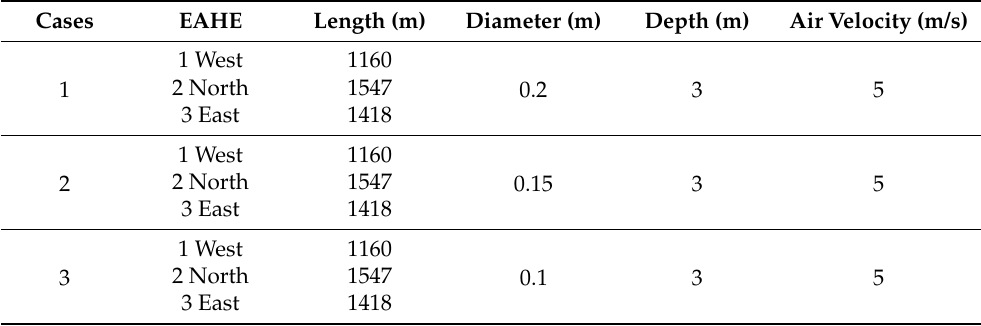
Table 7. EAHE specifications of cases 1, 2, and 3 with similar pipe lengths, installation depths, and air velocity but different pipe